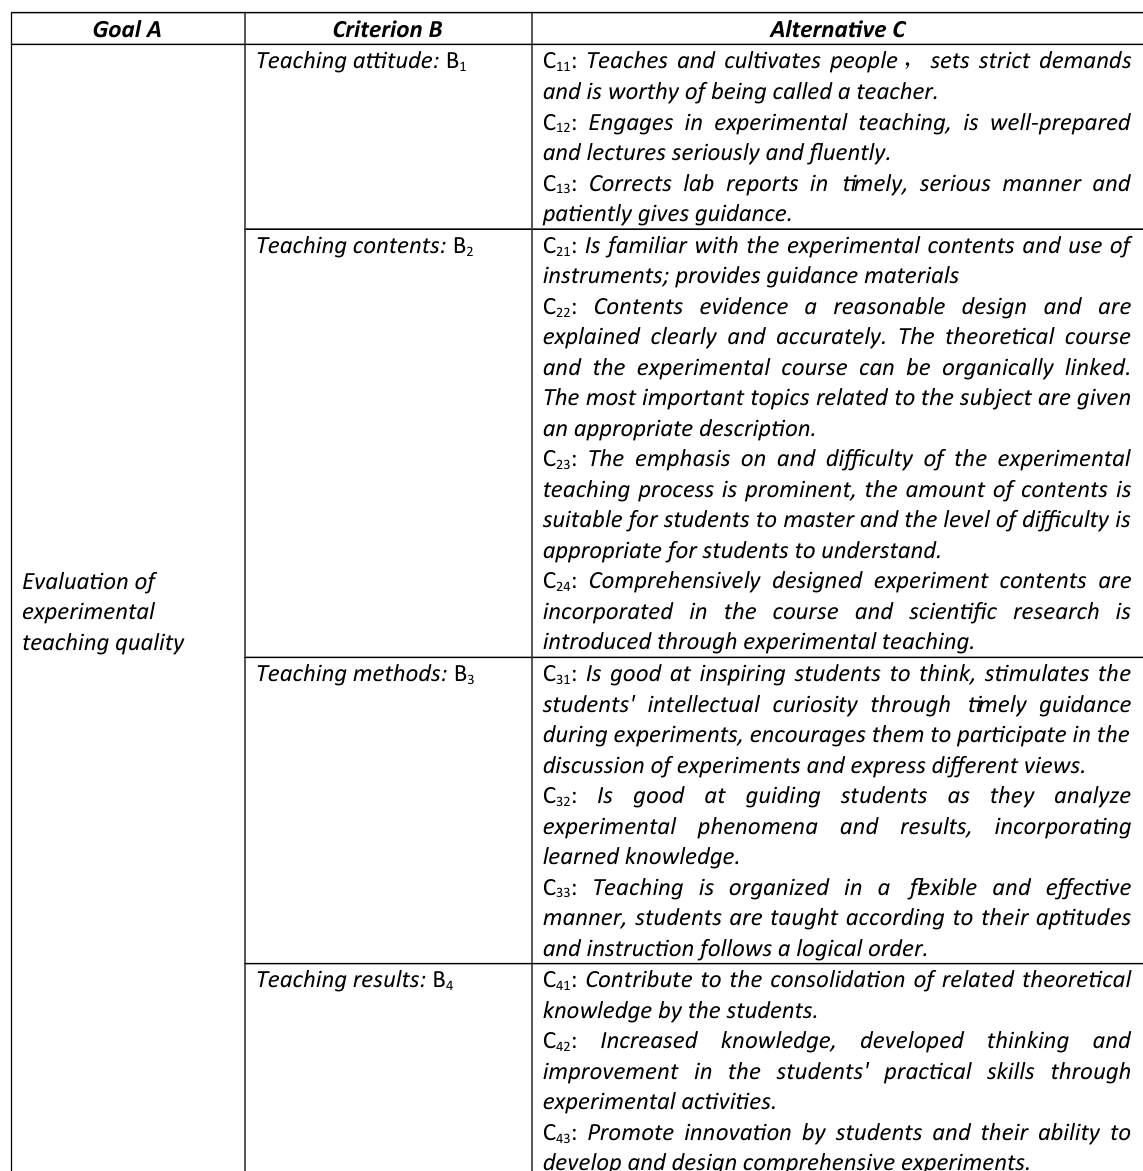
Table 1. Evaluation system assessing experimental teaching